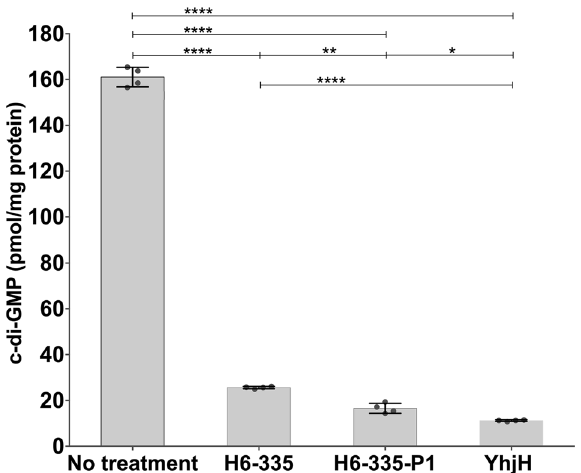
Fig. 3 Effect of H6-335 and H6-335-P1 on the c-di-GMP level of P. aeruginosa Δ wspF Δ pel Δ psl determined by HPLC coupled MS- MS. Bacteria were grown as 25 ml cultures in 250 ml Erlenmeyer fl asks in the presence of 100 μ M H6-335, 100 μ M H6-335-P1, or 0.05% DMSO as control. Following 8 h of growth (early stationary phase), samples for c-di-GMP and protein quanti fi cation were collected from each of the three cultures. P. aeruginosa Δ wspF Δ pel Δ psl /pYhjH G containing plasmid pYhjH G -encoded YhjH phosphodiesterase was included as an additional control. Mean and standard deviation (bars) of c-di-GMP contents normalized to protein contents are shown for four biological replicates ( n = 4). Signi fi cance levels are based on one-way ANOVA analysis with Sidak ’ s multiple compar- isons test (* p < 0.05, ** p < 0.01, **** p < (Fig. 1b). The potency of the H6-335-P1 compound was con fi rmed with HPLC coupled tandem-MS analysis, which showed that 100 μ M H6-335-P1 reduced the total cellular c-di-GMP content of the P. aeruginosa Δ wspF Δ pel Δ psl strain by 90% compared with the